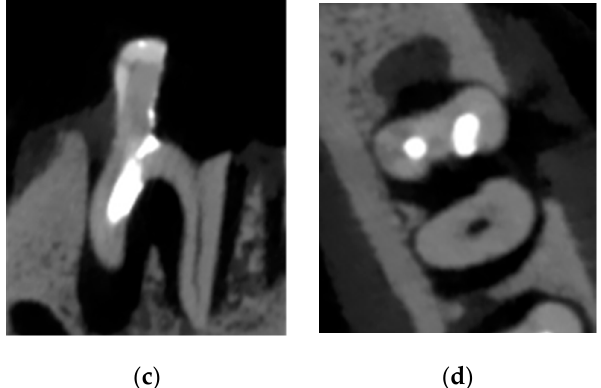
Figure 2. Digital periapical radiographs with ( a ) perpendicular and ( b ) distal horizontal angles and CBCT images in ( c ) sagittal and ( d ) axial views of a tooth with strip perforation of the mesiobuccal root canal.